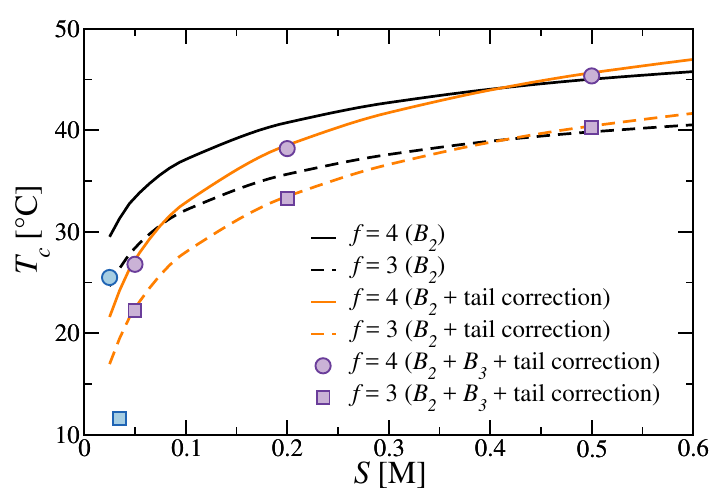
Figure 7. Critical temperature as function of salt concentrations, estimated by taking into account the contribution of the the repulsive tails, as is done in [32]. Circles and solid lines refer to tetramers ( f = 4); squares and dashed lines refer to trimers ( f = 3). The data has been obtained with the second-order virial approximation [31] (orange and black lines for data obtained with and without tail corrections), the third-order virial approximation (full violet symbols) and experiments [8] (full blue symbols). Data obtained with thermodynamic integration (TI) overlap with the B 2 + B 3 symbols and are therefore omitted for